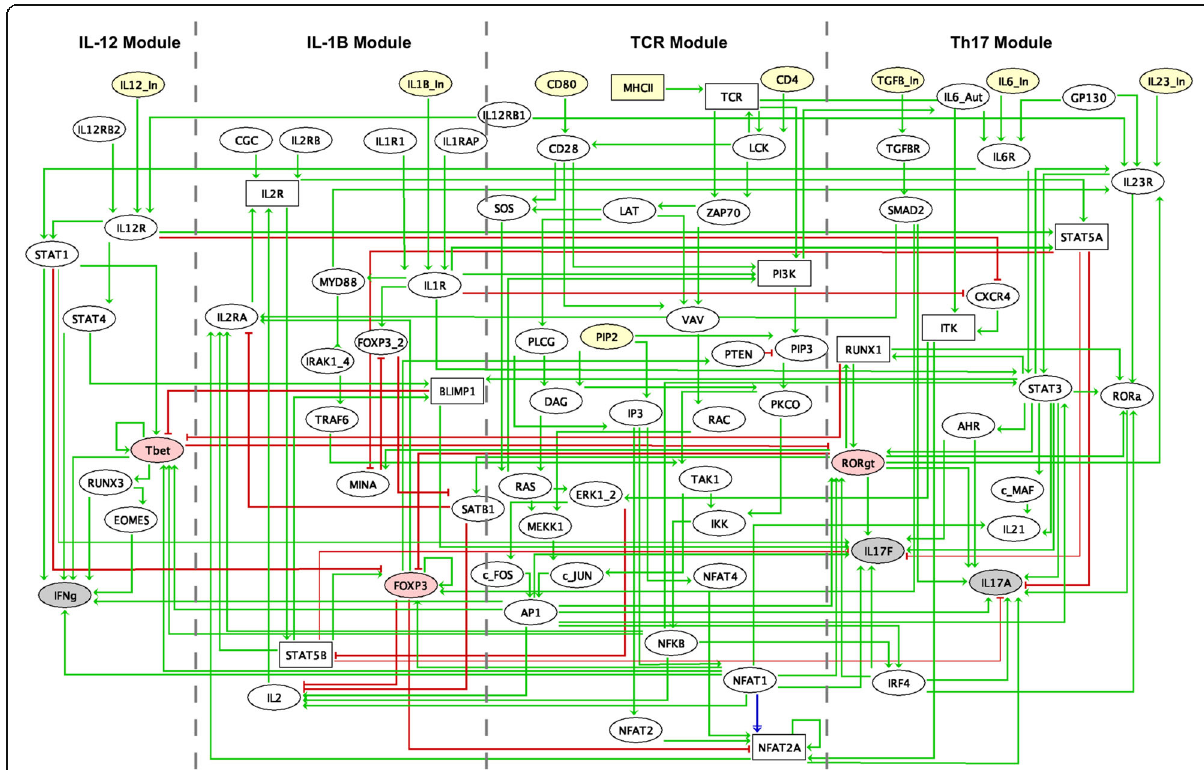
Fig. 2 Regulatory graph integrating the interactions inferred from the literature, databases and ChIP-seq data meta-analyses. Four CD4 + T cell differentiation modules are considered to construct the regulatory graph: Th1, IL-1 β , TCR and Th17 modules. Nodes represent genes and arrows denote regulatory interactions. Yellow nodes denote inputs, pink nodes denote master transcription factors, and gray nodes denote outputs. Ellipses represent Boolean components, while rectangles represent the ternary components. Green and red edges correspond to activations and inhibitions, respectively. Further information about each node, including supporting references, can be found in Supplementary Table